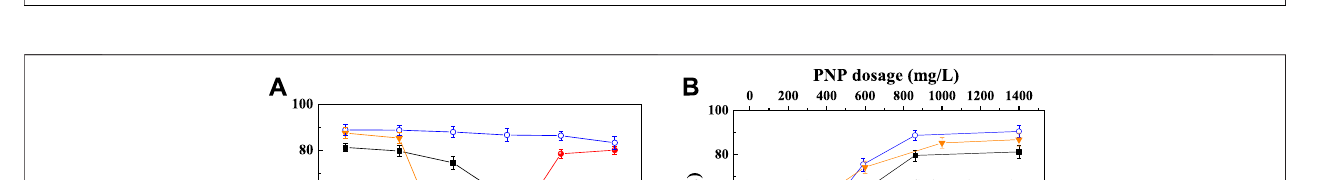
FIGURE 2 | XRD graphics of (A) smithsonite, (B) quartz, and (C) PNP.